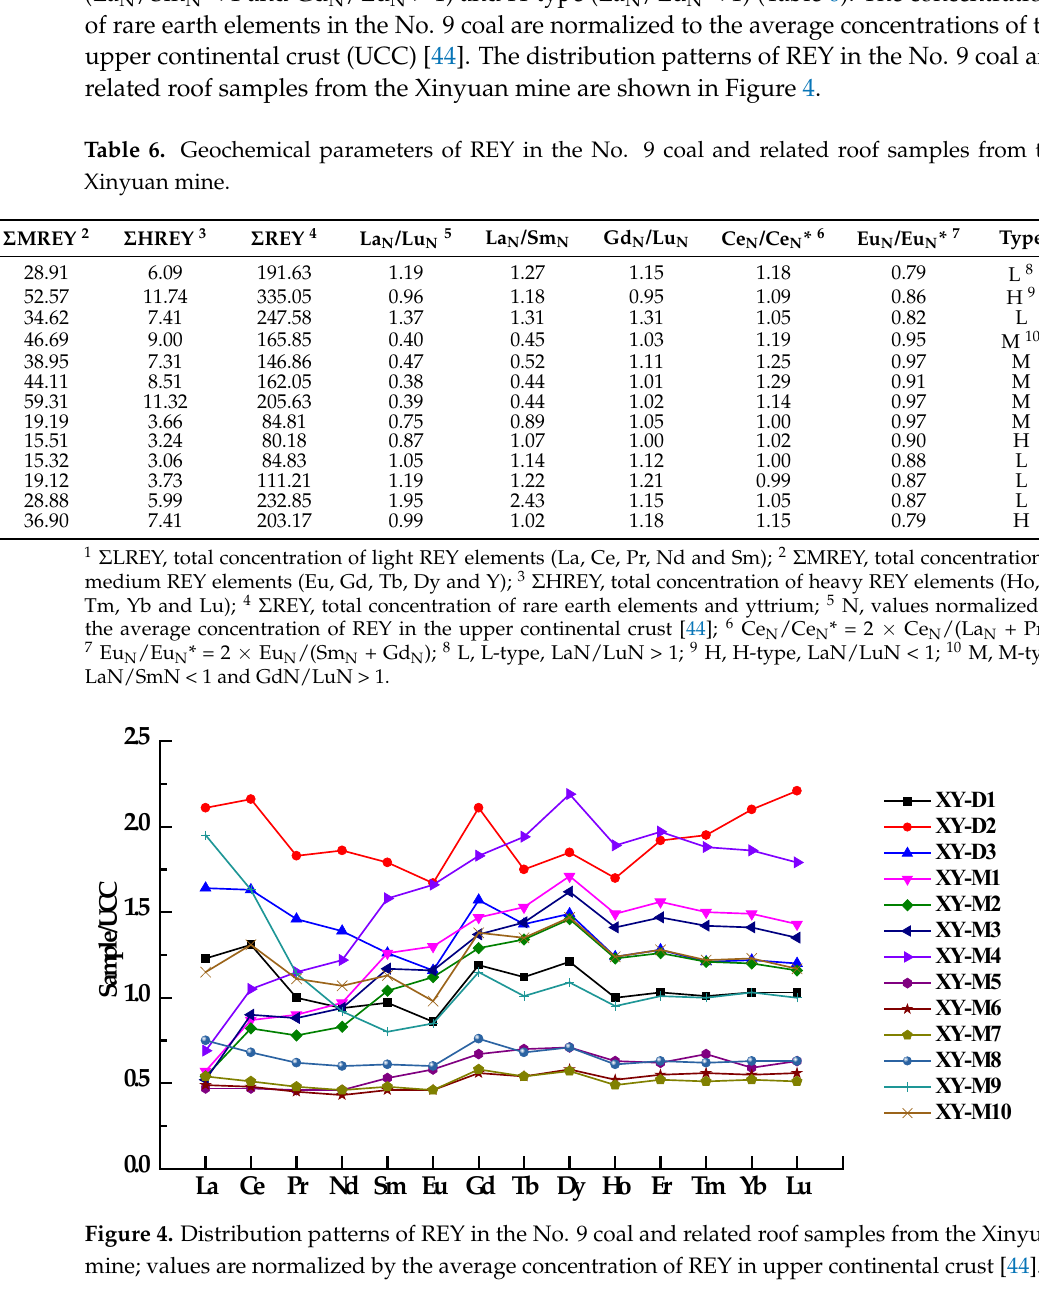
Table 6. Geochemical parameters of REY in the No. 9 coal and related roof samples from the Xinyuan mine.